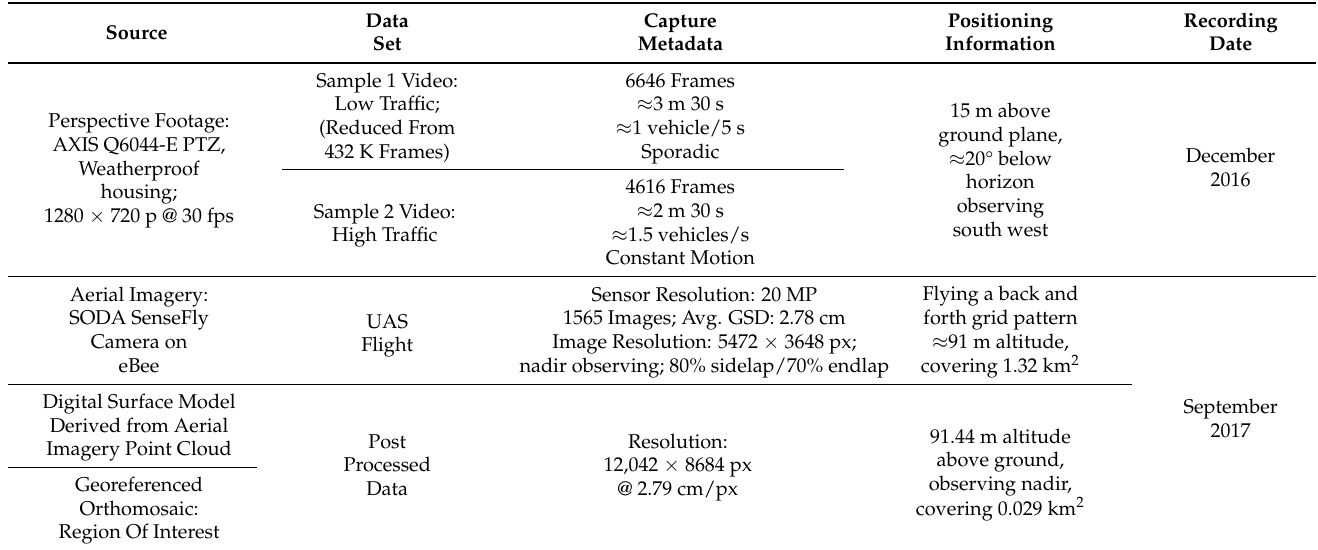
Table 1. Dataset